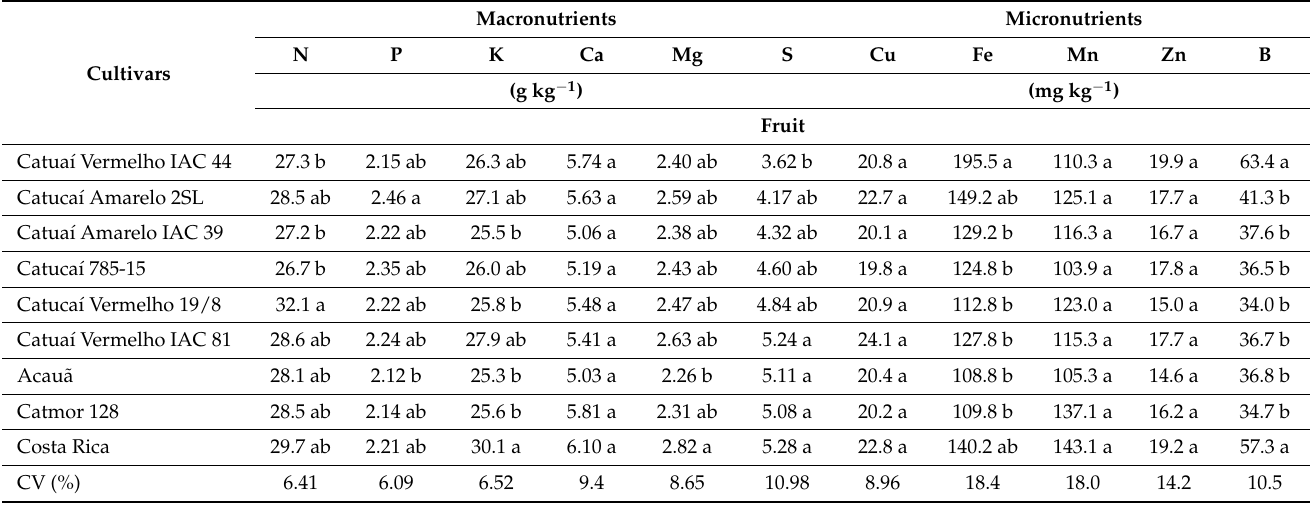
Table 6. Nutrients accumulated in the fruit of nine Coffea arabica cultivars, grown in the Gorongosa Mountain region, Gorongosa National Park, Sofala,